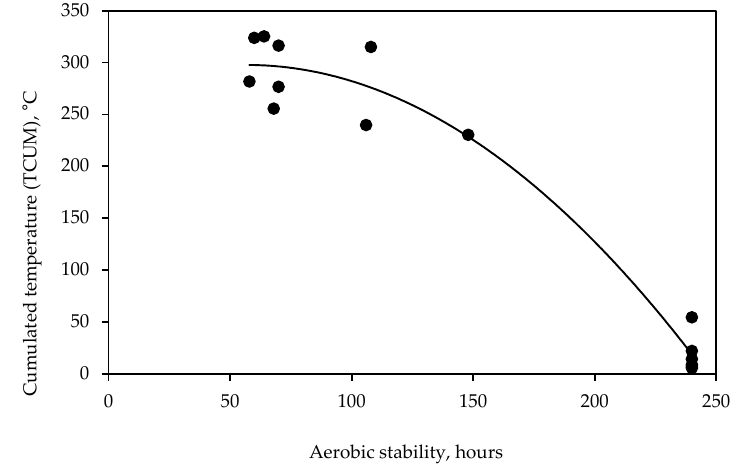
Figure 3. Relationship between the aerobic stability (x) and the cumulated temperature (y) in early-cut rye silage treated with additives of di ff erent type and composition and stored for 64 days upon subsequent air exposure for 240 h. R 2 = 0.96, RMSE = 27.2, p < 0.001, n =